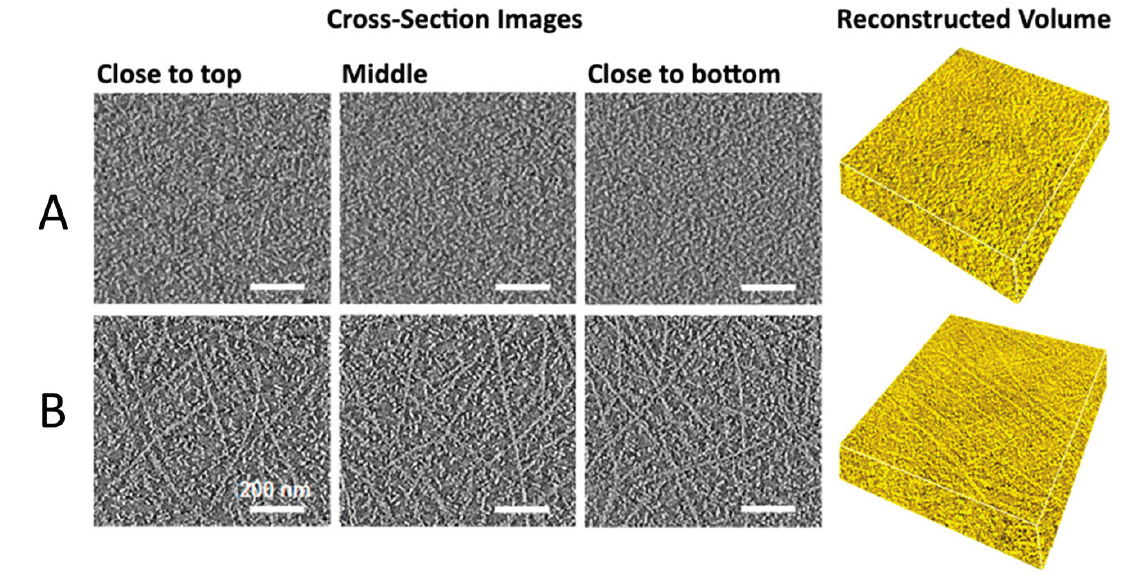
Figure 3. Cross-section images obtained by electron tomography from the top to bottom along the plane of the active layer for ( A ) a conventional bulk heterojunction and ( B ) a nanowire-based heterojunction, with reconstructed 900 × 900 × 200 nm volumes. Adapted from [60] with permission from the American Chemical Society. Scale bar: 200